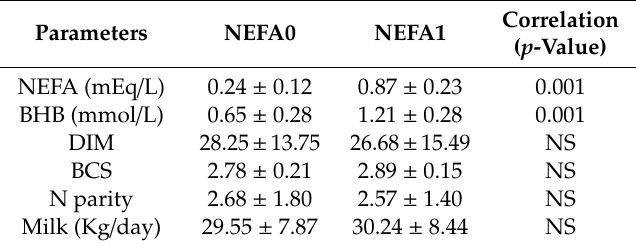
Correlation ( p -Value)